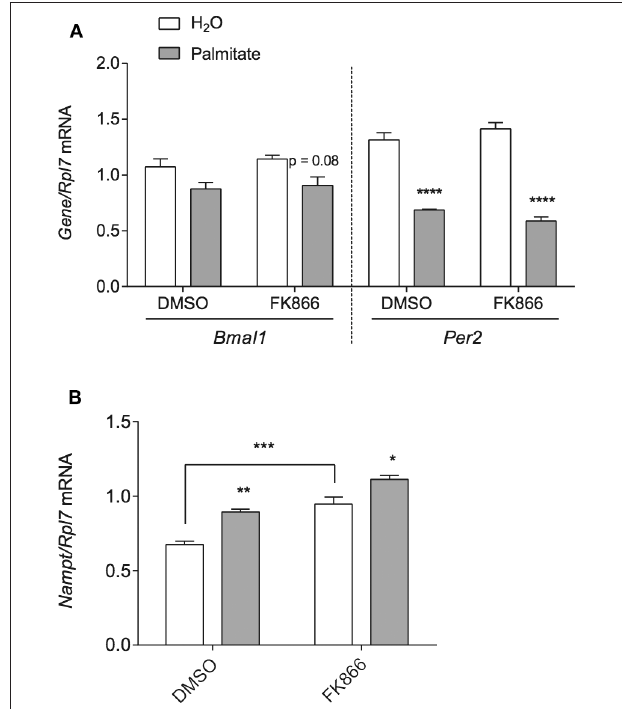
FIGURE 3 | NAMPT activity does not mediate the repression of Bmal1 nor Per2 mRNA by palmitate. mHypoE-46 neurons were pretreated for 1h with 10nM FK866 or DMSO vehicle control, then treated with 50 µ M palmitate for 24h. Changes in (A) Bmal1 and Per2 mRNA or (B) Nampt mRNA were assessed by qRT-PCR. n = 4 independent experiments. Data are expressed as mean ± SEM, * P < 0.05,** P < 0.01,*** P < 0.001,**** P < 0.0001. Statistical analysis was performed by two-way ANOVA with the Tukey post hoc